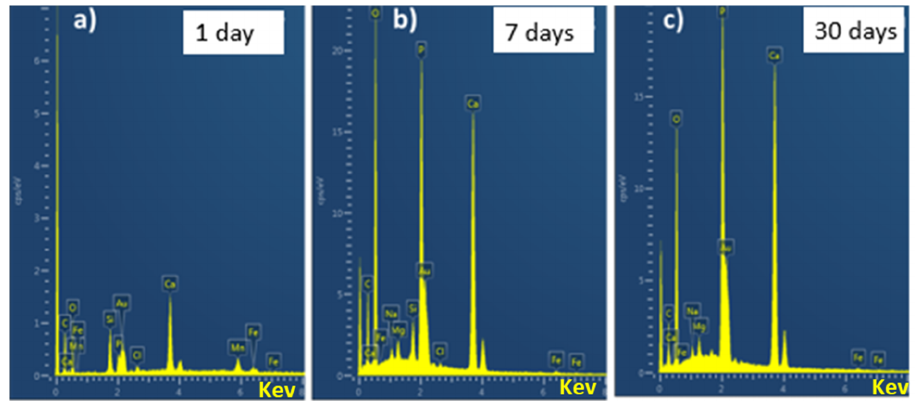
Figure 8. EDX analysis of synthesized Ag-Sr MBGNs after immersion in SBF for ( a ) 1 day, ( b ) 3 days, and ( c ) 1 month.